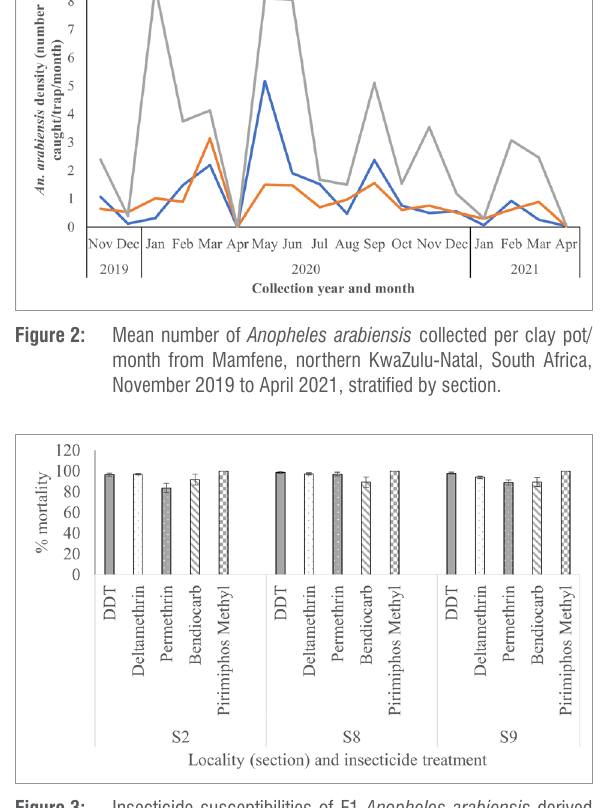
Insecticide susceptibilities of F1 Anopheles arabiensis derived from wild-collected material from Mamfene, northern KwaZulu- Natal Province, South Africa, 2019–2021. Mean mortalities (%) and standard errors are shown for each insecticide by Mamfene section (S2, S8, and